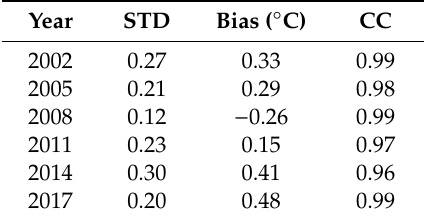
Table 6. Accuracy assessments of extracted LST patterns from 2002 to 2017. Year